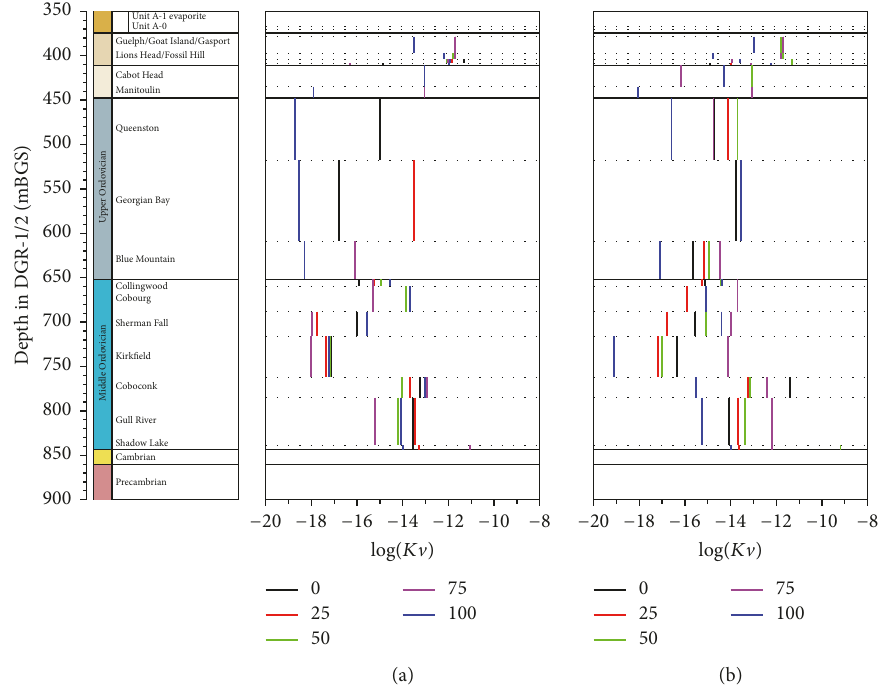
Figure 8: Calibrated vertical hydraulic conductivity using glaciation scenario nn9921. Coloured lines represent different percentages of ice- sheet thickness applied as excess head to the top boundary condition. Subfigure (a) uses present day environmental heads as the initial condition while subfigure (b) uses a hydrostatic head condition computed assuming